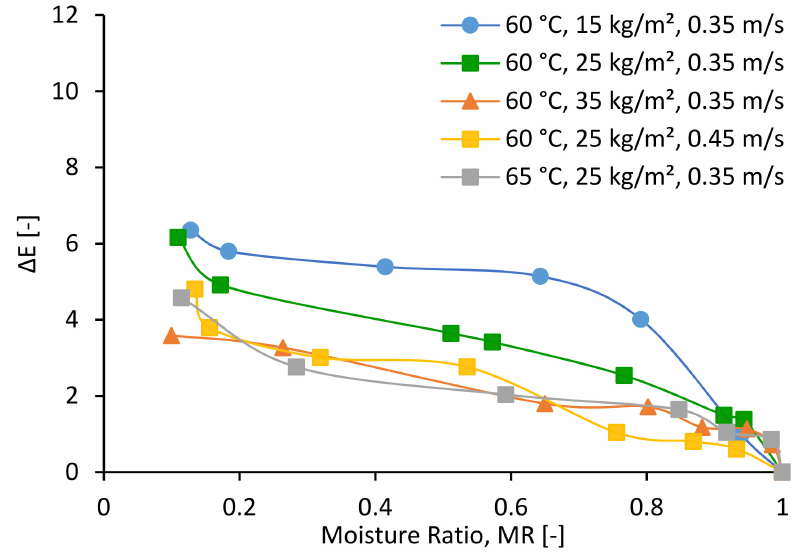
Figure 14. ∆ E as a function of moisture ratio (MR) for hops dried under di ff erent process settings and di ff erent bulk